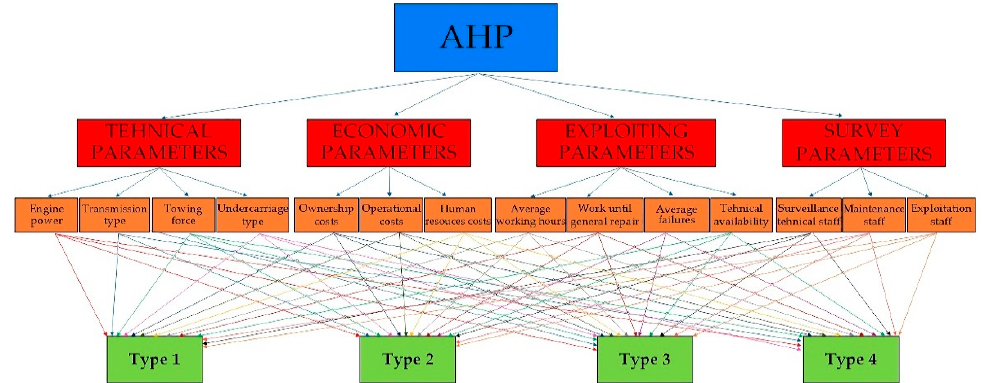
Figure 5. The structure of the model in choosing the dozers by applying the AHP method.